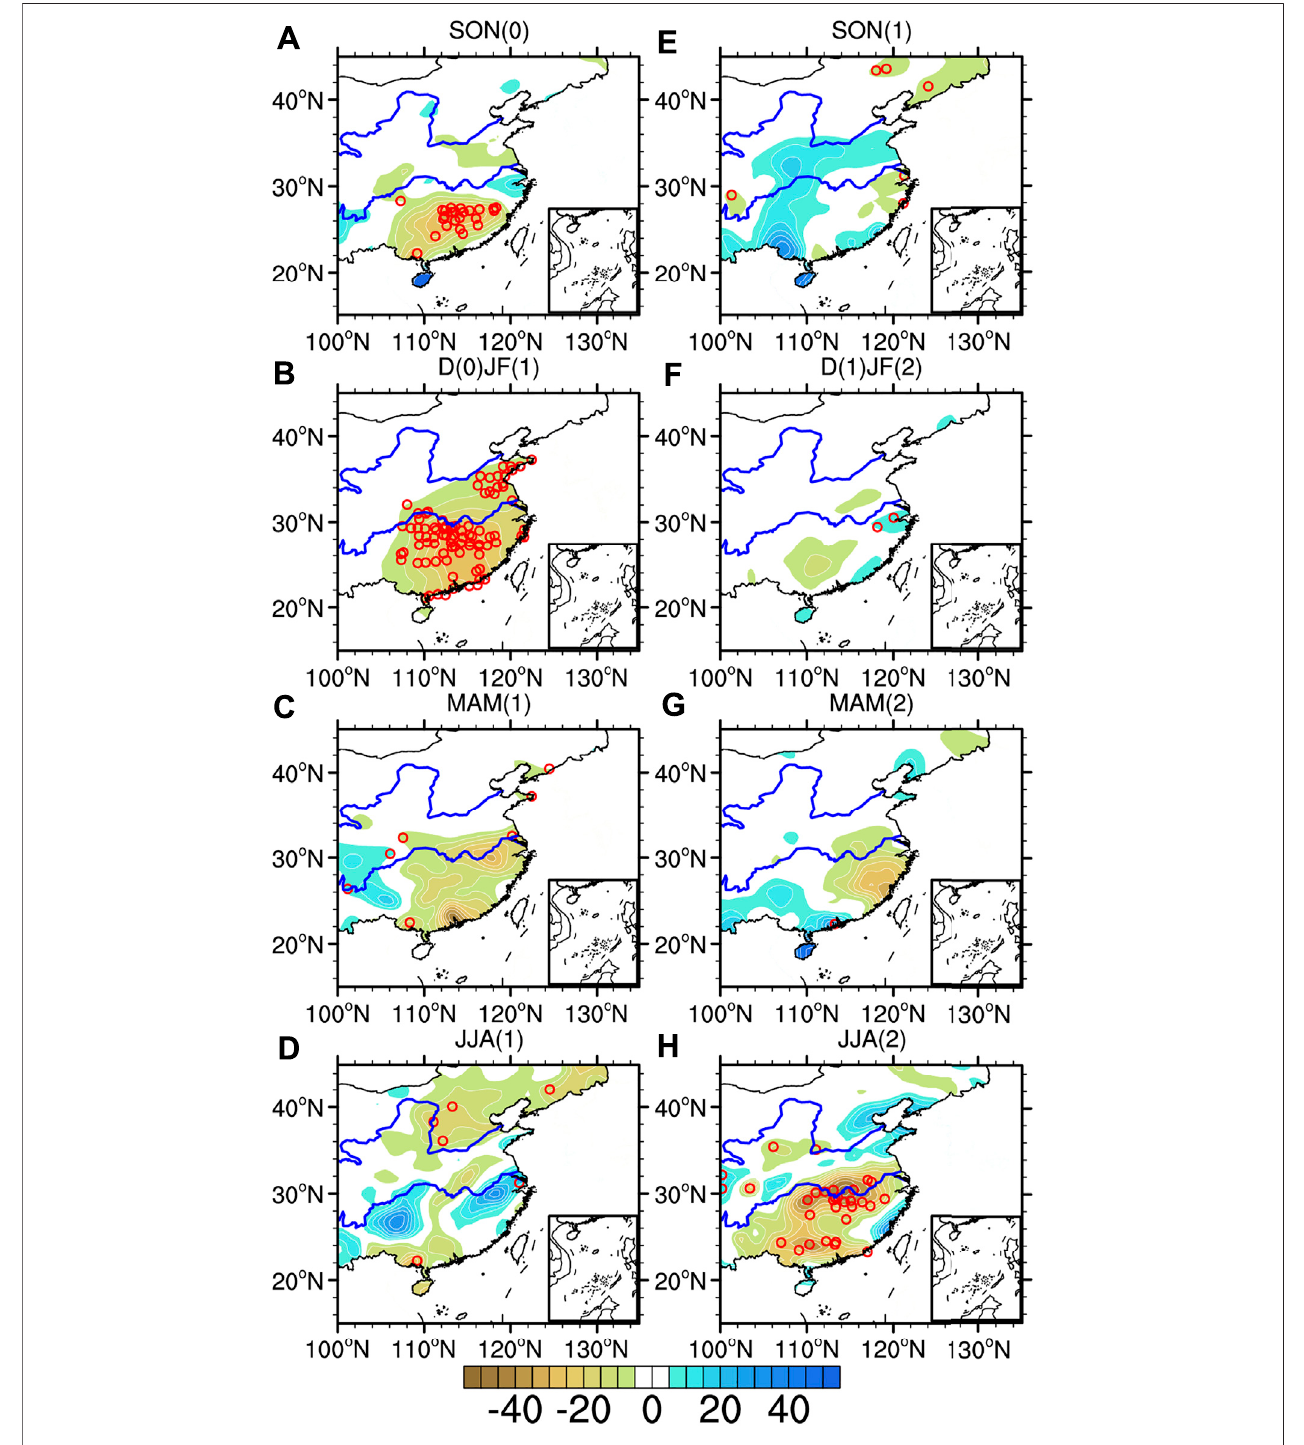
FIGURE 3| Composites ofprecipitation anomalies (units: mm) in southern China during (A) SON (0), (B) D (0) JF(1), (C) MAM (1), (D) JJA (1), (E) SON (1), (F) D (1) JF (2), (G) MAM (2), and (H) JJA (2). Red circles indicate values at 699 meteorological stations exceeding the 90% con fi dence level determined using a two-tailed Student ’ s t